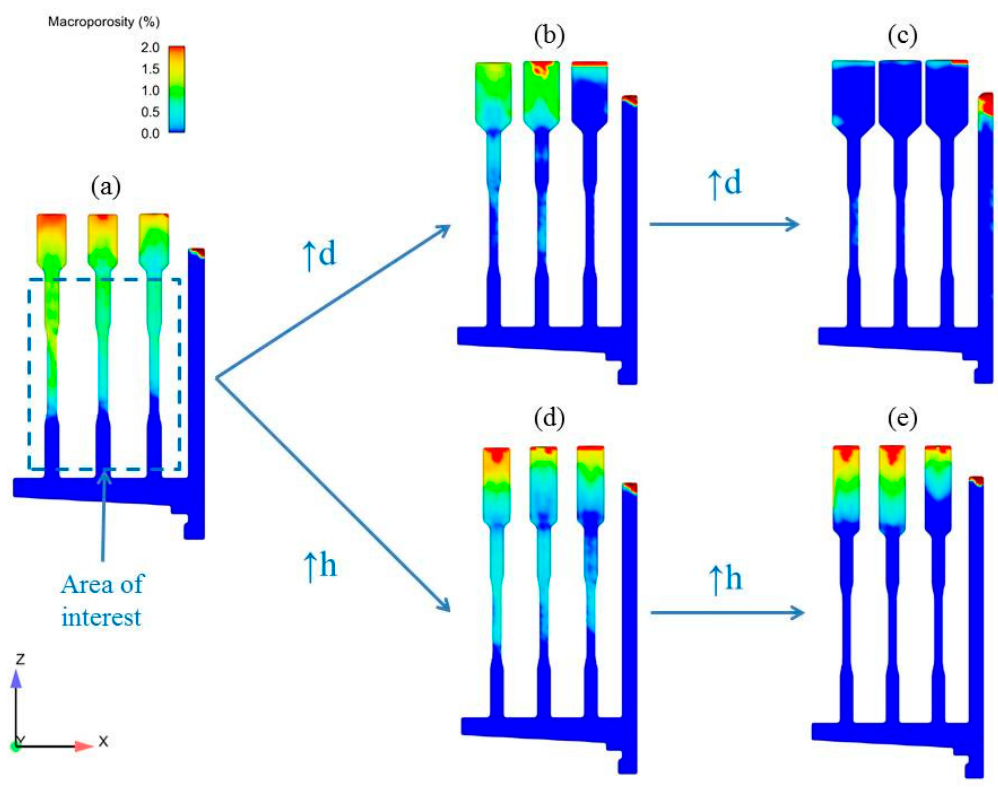
Figure 3. Effects of the riser dimensions on percentage macroporosity: ( a ) h = 49.41 mm/ d = 36 mm; ( b ) h = 49.41 mm/ d = 46 mm; ( c ) h = 49.41 mm/ d = 56 mm; ( d ) h = 103.42 mm/ d = 36 mm; and ( e ) h = 130.43 mm/ d = 36 mm.